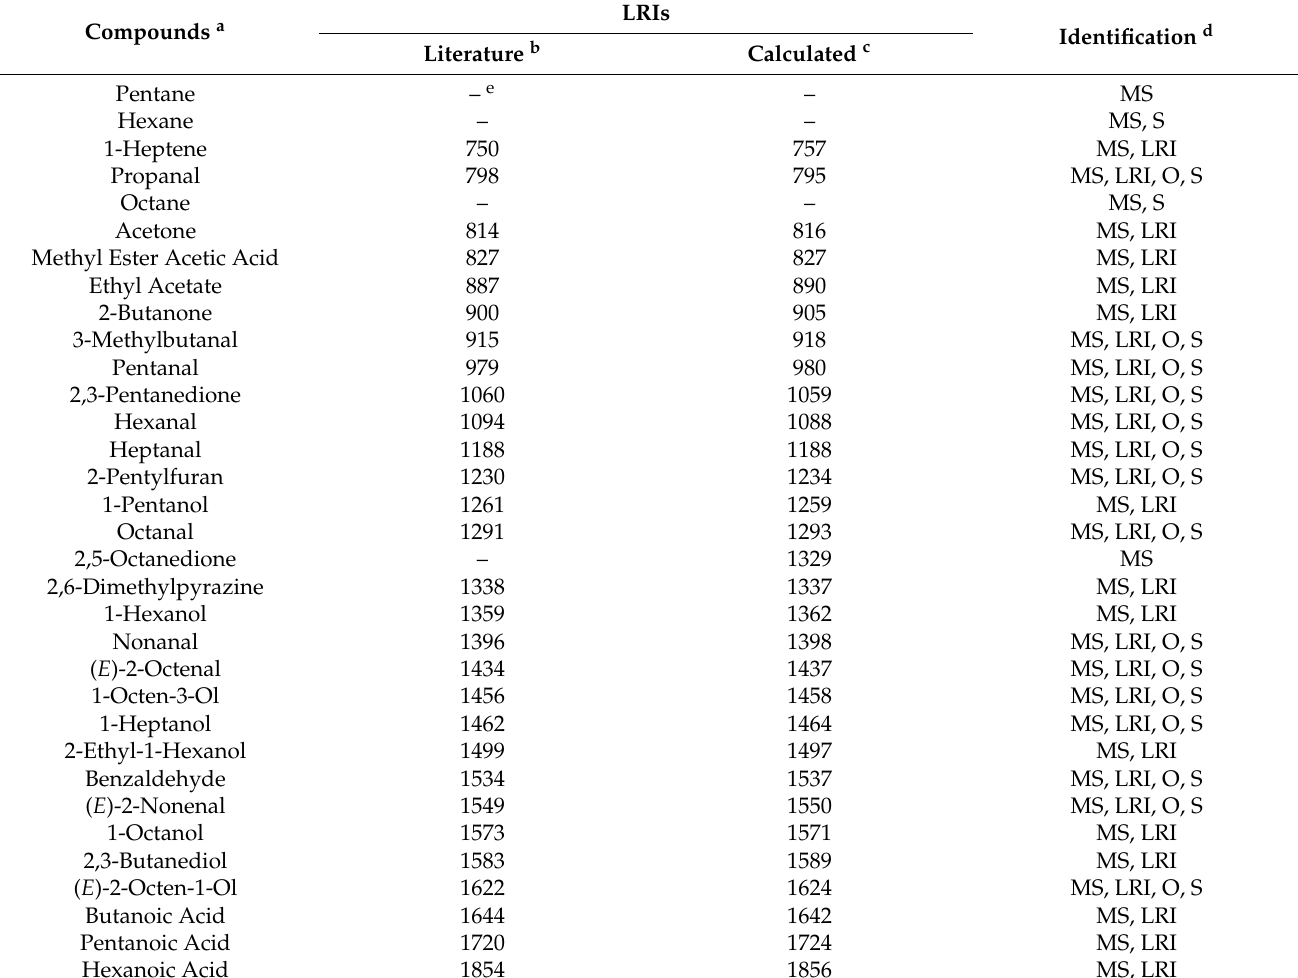
Table 1. Aroma compounds, linear retention indices (LRIs), and identification methods in the pre- and postrigor roasted mutton. Compounds a